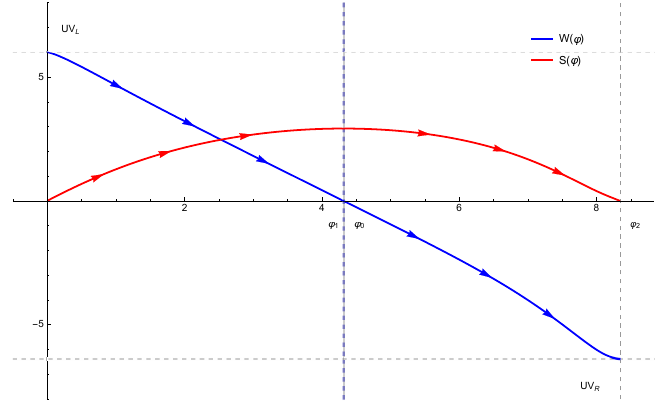
Figure 48 . When we move towards the top corner of the orange region in figure 10a, the ( Max ) solution gradually tends to the ( Max − , Max −